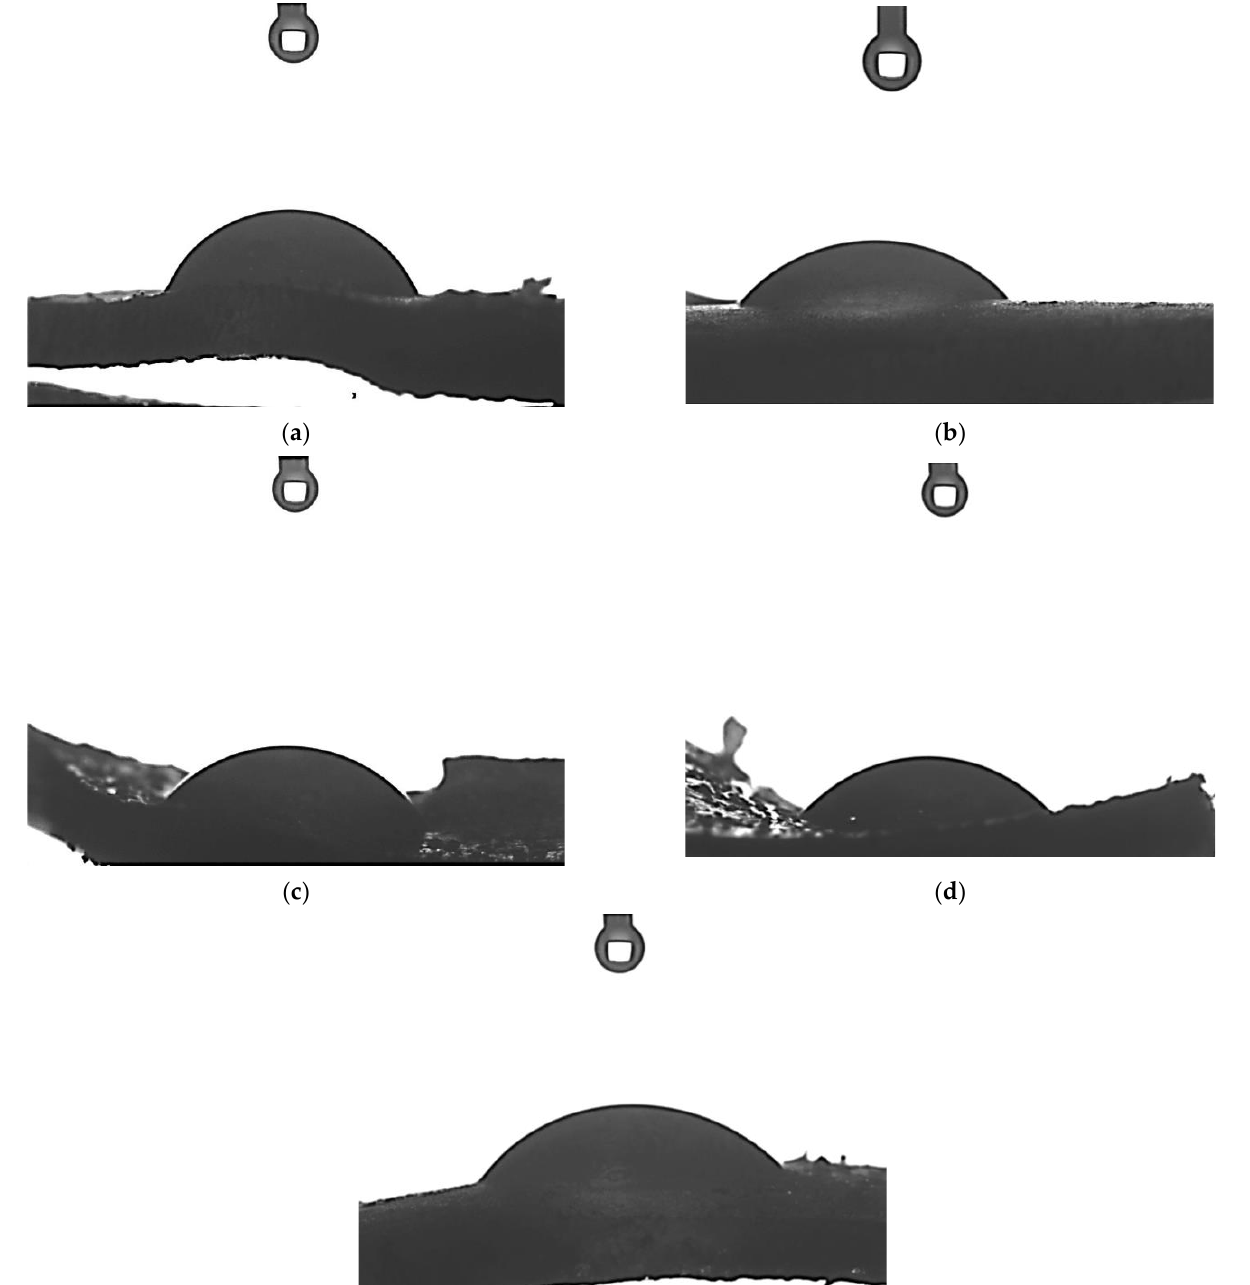
Figure 8. Images showing the wettability of sample 0.025/Photo ( a ), 0.075/Photo ( b ), 0.100/Photo ( c ), 0.125/Photo ( d ) and 0.150/Photo ( e ).